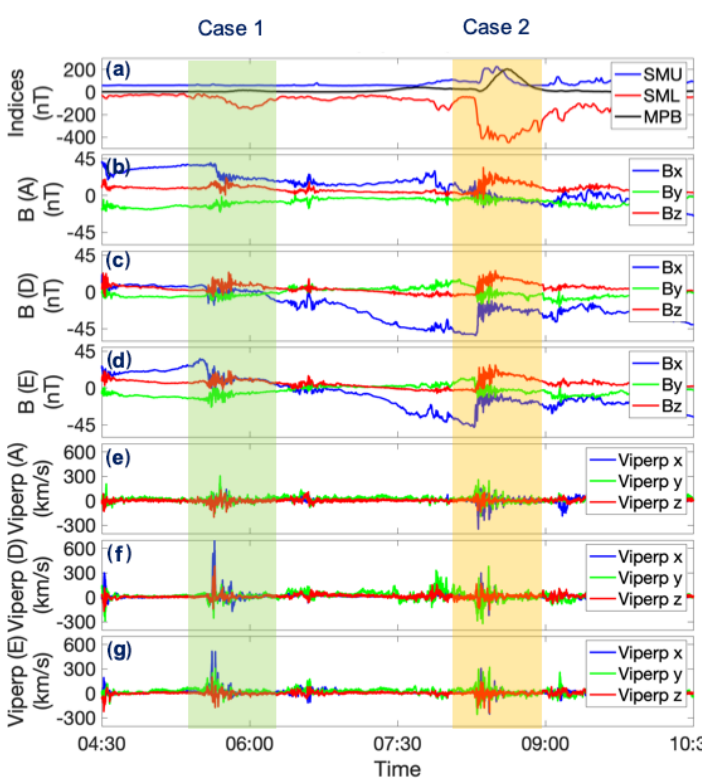
Figure 1. THEMIS spacecraft in situ measurements for fast flow burst Cases 1 and 2 that were observed on 25 December 2015. The pseudobreakup events are highlighted in green (Case 1), while the substorm fast flow burst events are highlighted in yellow (Case 2). (a) The auroral electrojet indices SMU, SML and MPB index, (b–d) the 3-D magnetic field measured by THEMIS A, D and E, respectively, and (e–g) the perpendicular ion velocity measured by THEMIS A, D and E,